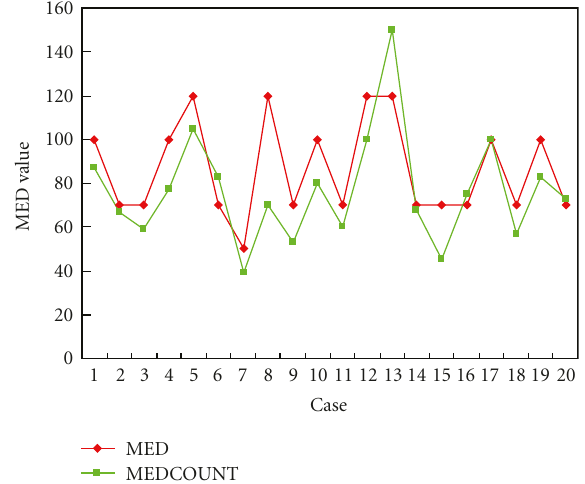
Figure 4: The individual MED value evaluated by conventional visual determination and mathematical model. MED: minimal ery- thema dose from visual assessment. MEDCOUNT: MED counted by mathematical